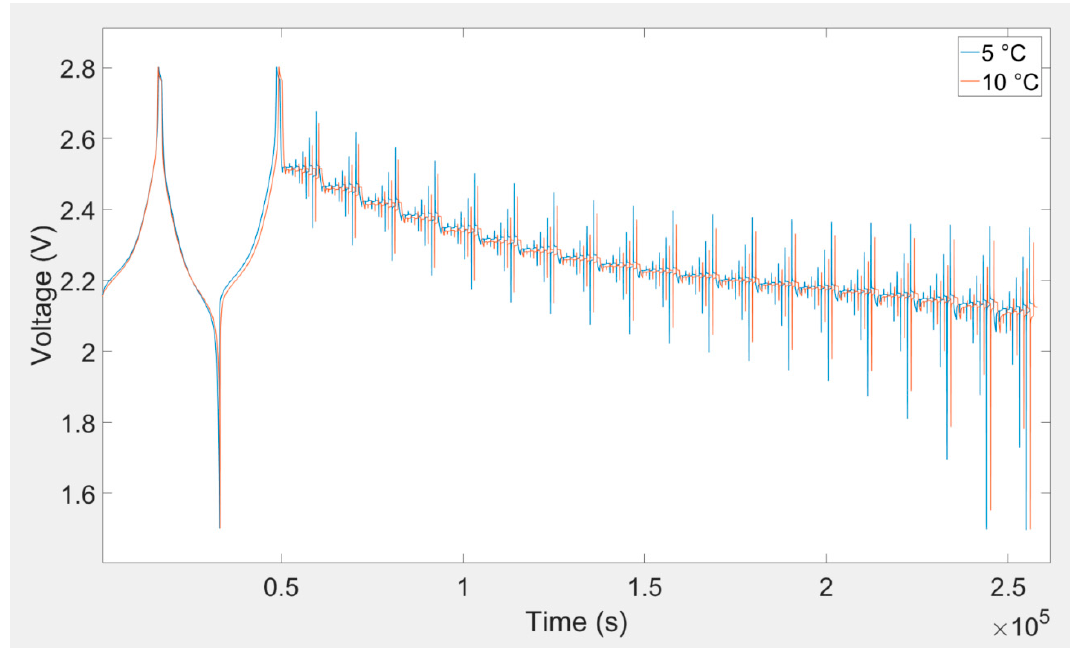
Figure 7. Battery cell voltage response owing to charging and discharging current pulse for 5 °C and 10 °C.